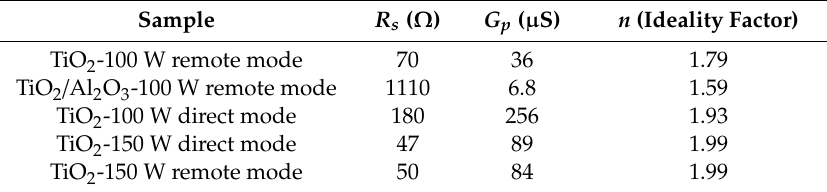
Table 1. Series parasitic resistance ( R s ), parallel parasitic conductance ( G p ) and the ideality factor calculated by the adjusting the J-V curves by the Ortiz-Conde